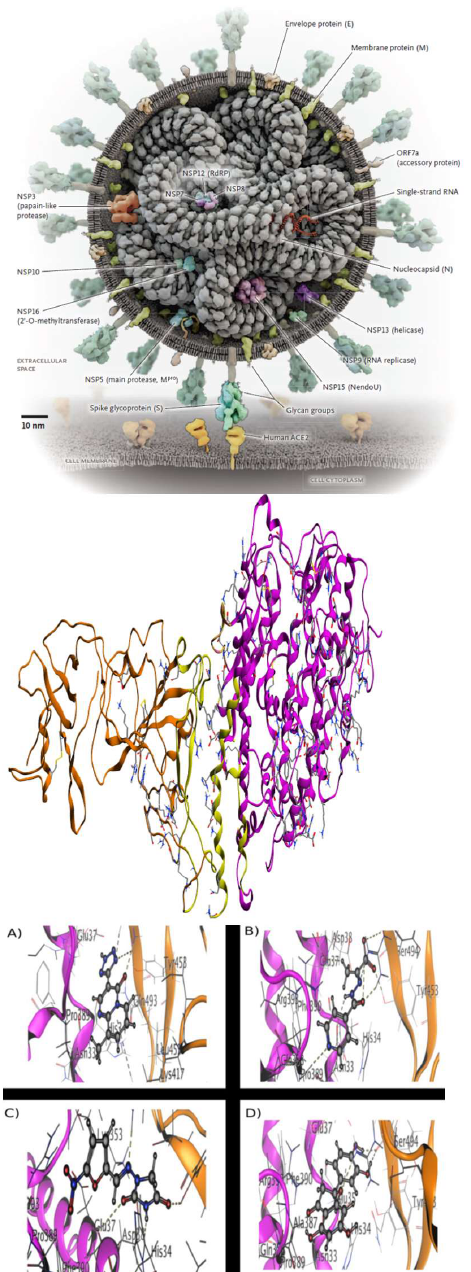
Fig. 15 . Top: SARS-CoV-2 virus (reprinted with permission from [89]. Copyright 2020 American Chemical Society). Middle: the S-protein of SARS- CoV-2 and human ACE2 receptor complex. Orange ribbons: the S-protein, purple: the ACE2, yellow: the interface targeted for docking (reproduced from [90]). Bottom: Four of the top scoring small-molecules binding within the S-protein-ACE2 interface. A) pemirolast. B) isoniazid pyruvate. C) Nitrofurantoin. D) Eriodictyol. Orange ribbons: the S-protein, purple: the ACE2 receptor (reproduced from [90]). These calculations required a knowledge of the dynamics of the target proteins on the BWAVES time